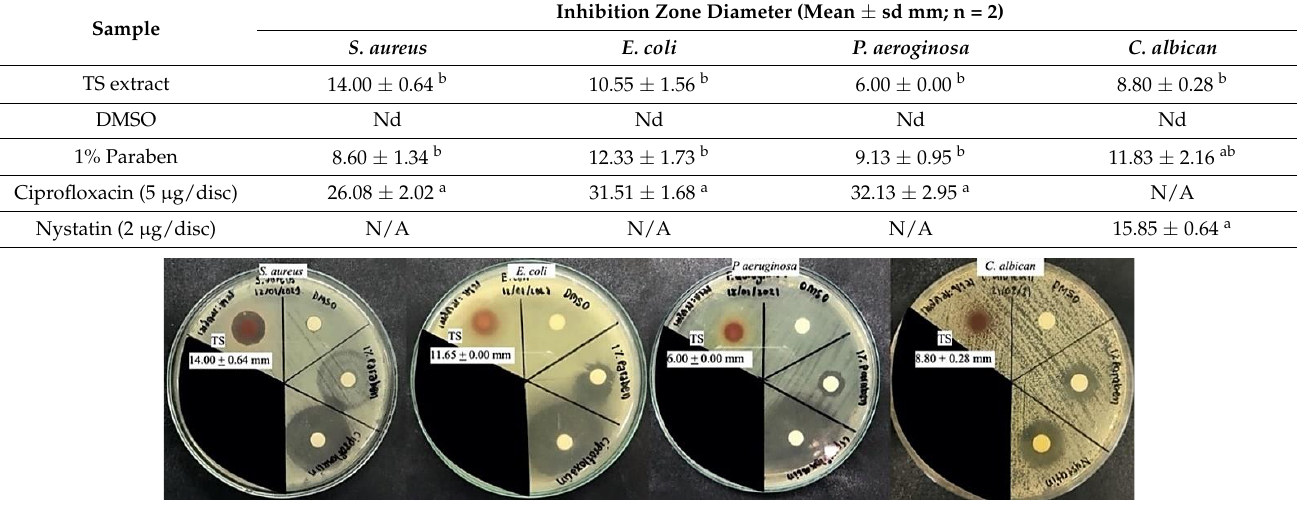
Table 2. Anti-microbial activities of the tamarind seed coat (TS) extract at a concentration of 250 mg/mL against S. aureus , E. coli , P. aeruginosa , and C. albicans were differently exhibited by various inhibition zone diameters. Furthermore, the determination was done compared to the controls: Dimethyl sulfoxide (DMSO, negative control); 1% Paraben (reference preservative); Ciprofloxacin (positive control).